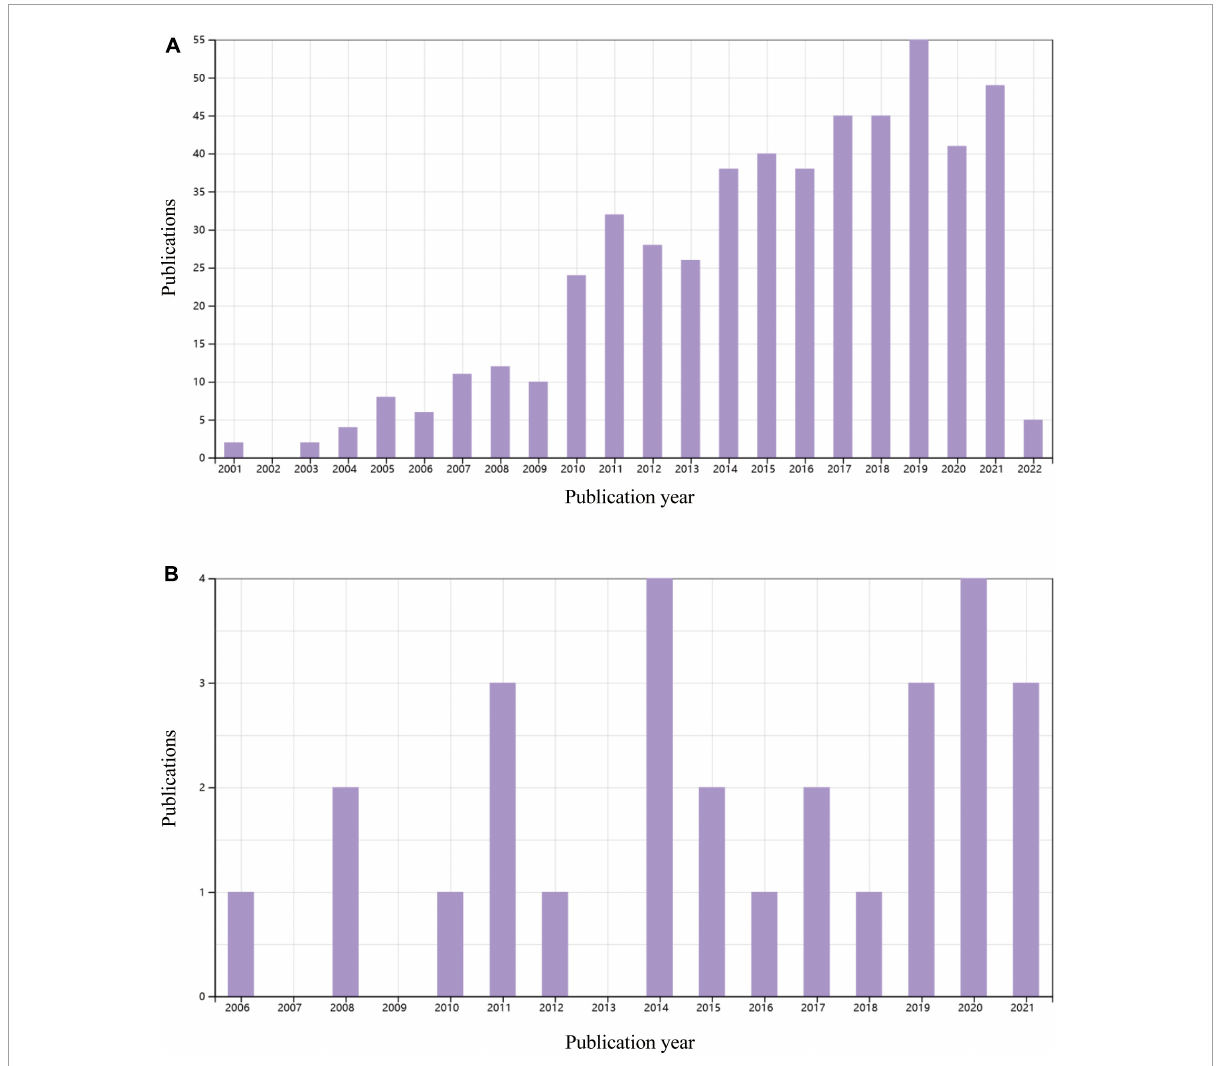
FIGURE3 Original publications over time related to cardiac regenerative research in rodents with permanent myocardial infarction of myocardial ischemia/reperfusion in the last 20 years. (A) 521 papers on a permanent myocardial infarction model. Data source: Web of Science, searched with the topics "myocardial infarction" AND ("cardiac regeneration" OR "heart regeneration") and then refined by document type "Articles" and MeSH headings of "Animals." (B) 28 articles using a myocardial ischemia/reperfusion model. Data source: Web of Science, searched with the topic "ischemic/reperfusion" AND ("cardiac regeneration" OR "heart regeneration") and then refined by document type "Articles" and MeSH headings of "Animals." Reviews, meeting papers, and editorial materials were excluded from both (A,B)